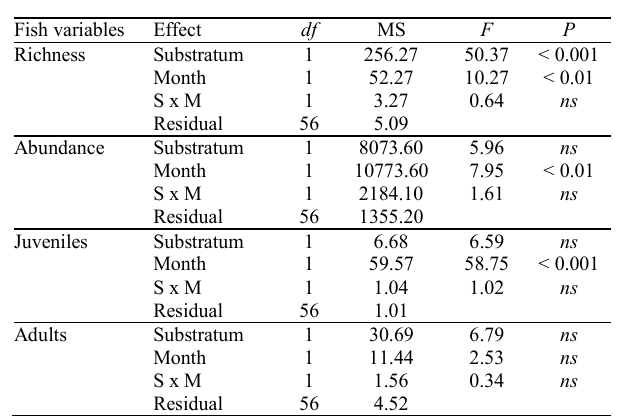
Table 5. Results of factorial ANOVAs testing the effects of substratum type, sampling month and their interaction term on fish variables from 15 permanent consolidated substratum (CS) stations and 15 permanent unconsolidated substratum (US) stations. ns : non-significant